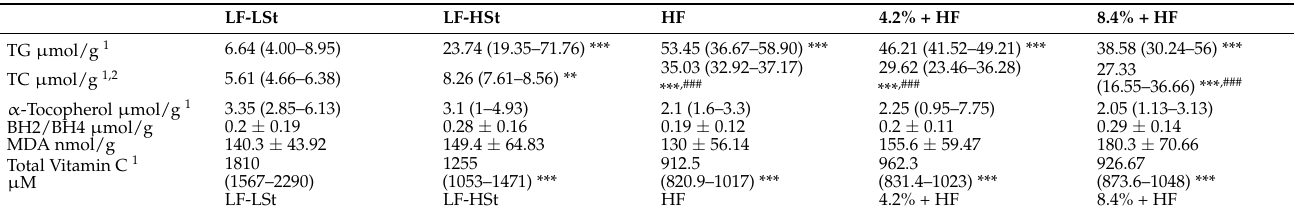
Table 2. Liver biochemical markers.